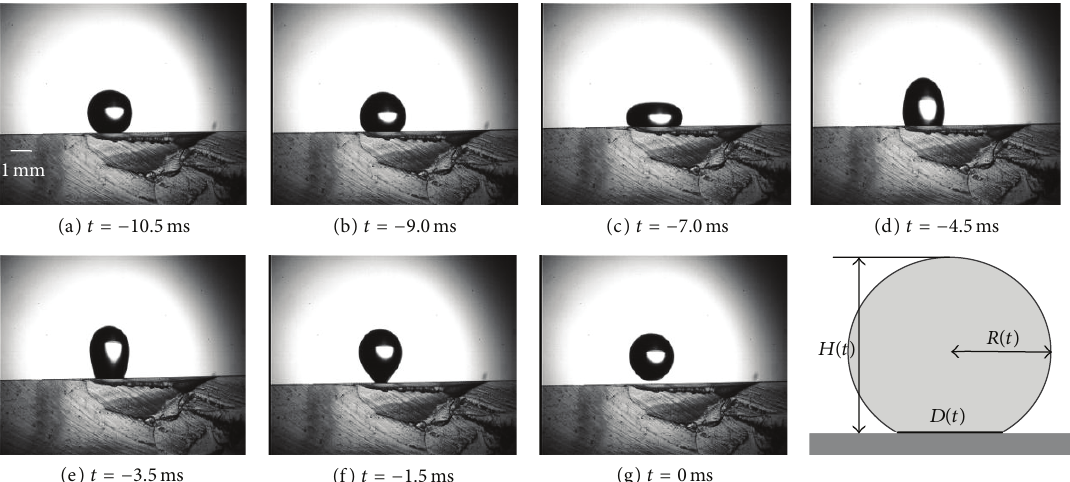
Figure 4: High speed images of the droplet bouncing-off from a vibrating plane ( 𝑓 = 70 Hz, 𝐴 = 0.31 mm). The value of 𝑡 for each image indicates a time relative to the moment ( 𝑡 = 0 ) the drop bounces off from the surface.